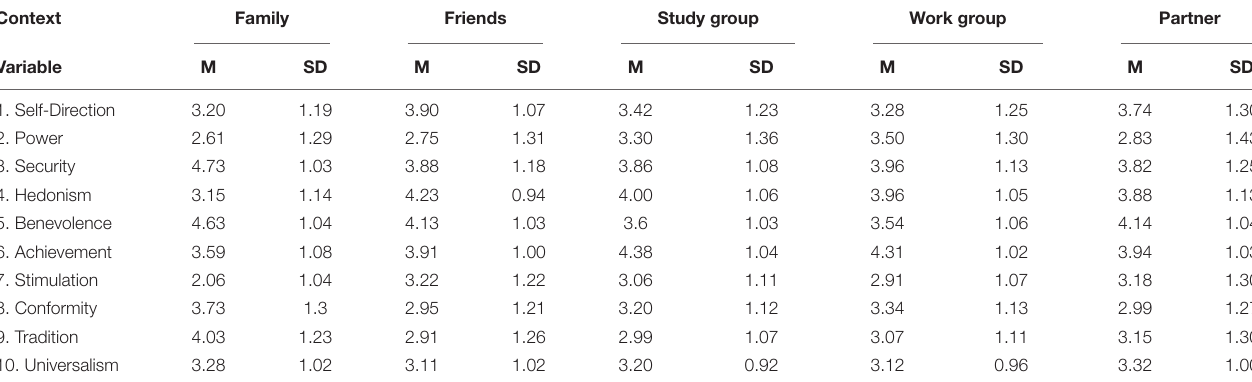
TABLE 2 | Means and standard deviations of value types of the social contexts subjectively reported by participants. Context Family Friends Study group Work group